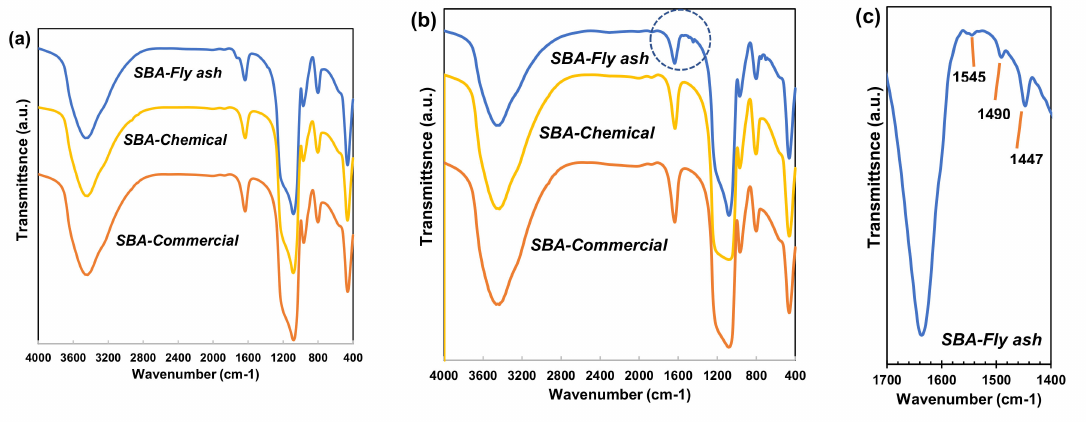
Figure 6. Fourier transform infrared ( FTIR) spectrums of ( a ) original SBA-15 samples; ( b ) pyridine-adsorbed SBA-15 samples in the region of 400–4000 cm − 1 , and ( c ) SBA-15-FA sample in the region of 1400–1700 cm − 1 ,